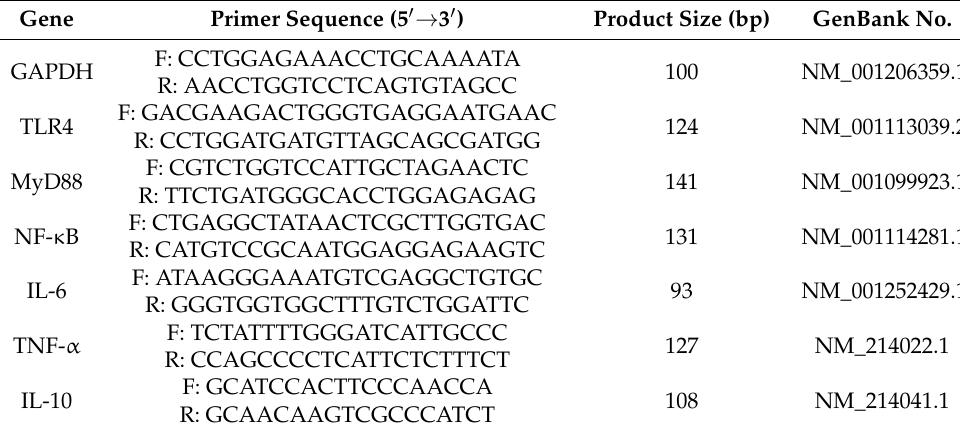
Table 1. Primers used in the real-time PCR